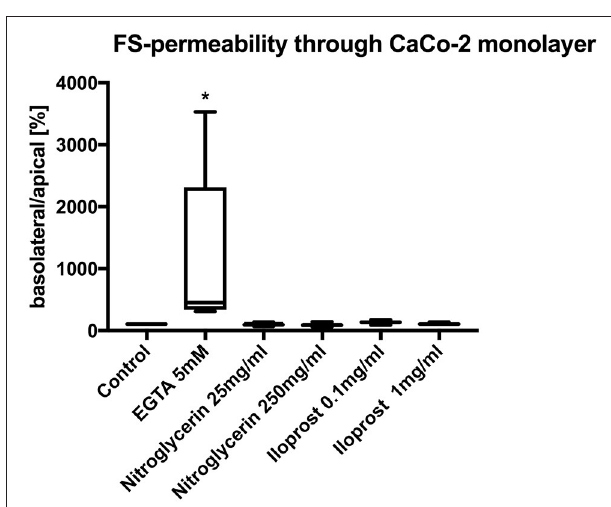
FIGURE 3 | Relative translocation of FS over the epithelial barrier from the apical to the basolateral compartment after incubation with iloprost or nitroglycerin compared to the control group. 5mM EGTA served as the positive control. Data are shown as percentage of the control value (median/min/max. * p < 0.05 vs. control, n =